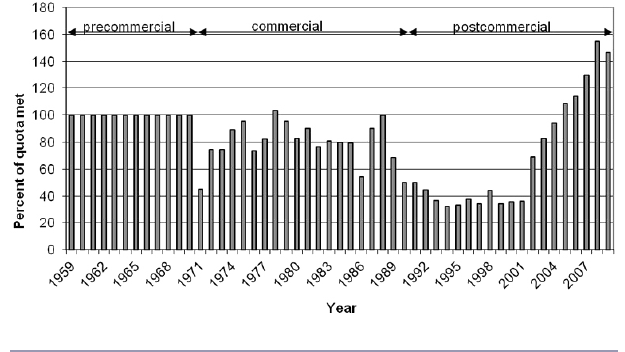
Fig. 4 . The percent of quota actually harvested in the Taimyr reindeer herd from 1959-2010. Note: in the precommercial period harvest was not monitored and was assumed to equal the number of permits issued based on local indigenous needs.